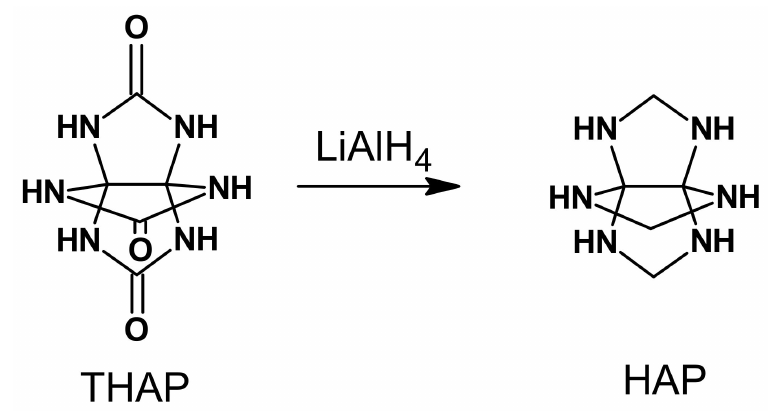
Figure 8. Reduced